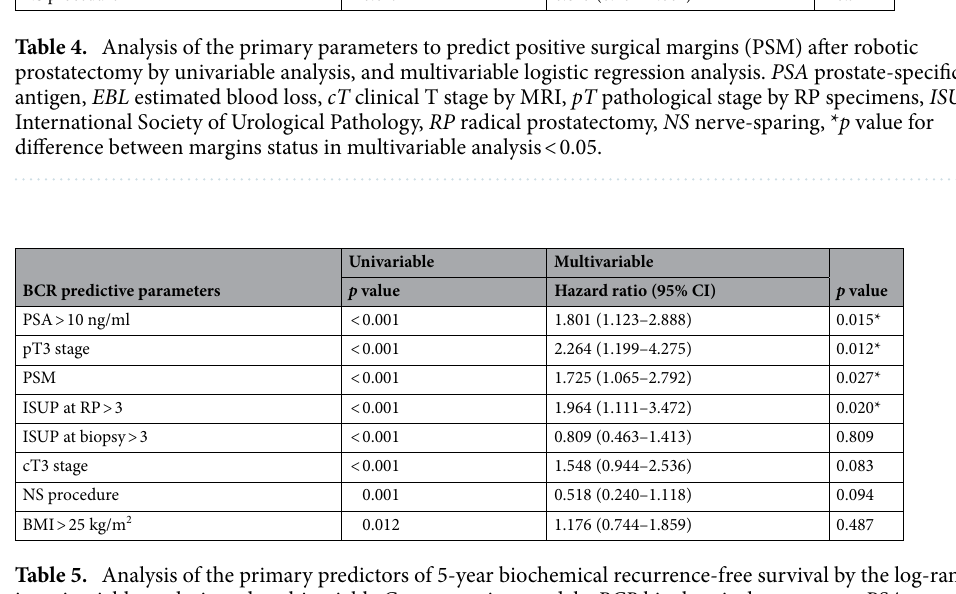
Table 5. Analysis of the primary predictors of 5-year biochemical recurrence-free survival by the log-rank test in univariable analysis and multivariable Cox regression models. BCR biochemical recurrence, PSA prostate- specific antigen, pT pathological T, PSM positive surgical margin, ISUP International Society of Urological Pathology, RP radical prostatectomy, cT clinical T, NS nerve-sparing, BMI body mass index. * p value for difference between biochemical recurrence in multivariable analysis <